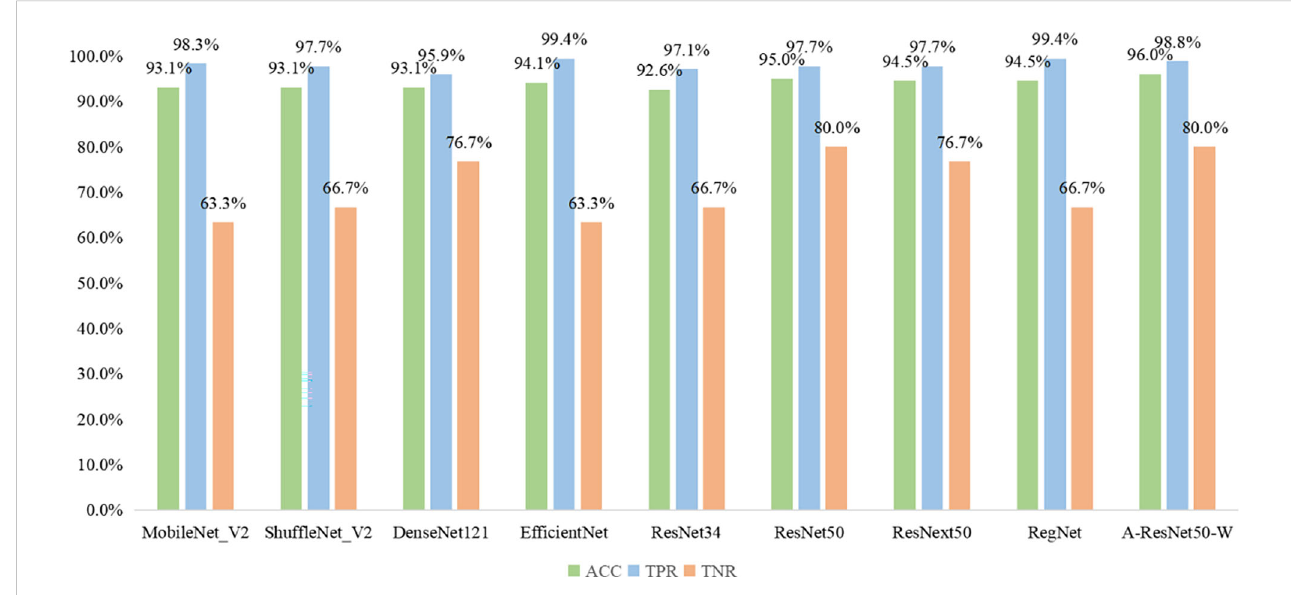
FIGURE 8 ROC curves of the proposed model vs. radiologists in the testing set.